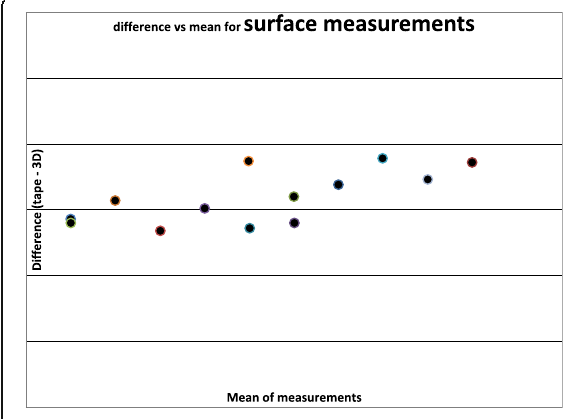
Fig. 2 Difference between manual and computer calliper measurements Fig. 3 Difference vs. mean for surface measurements